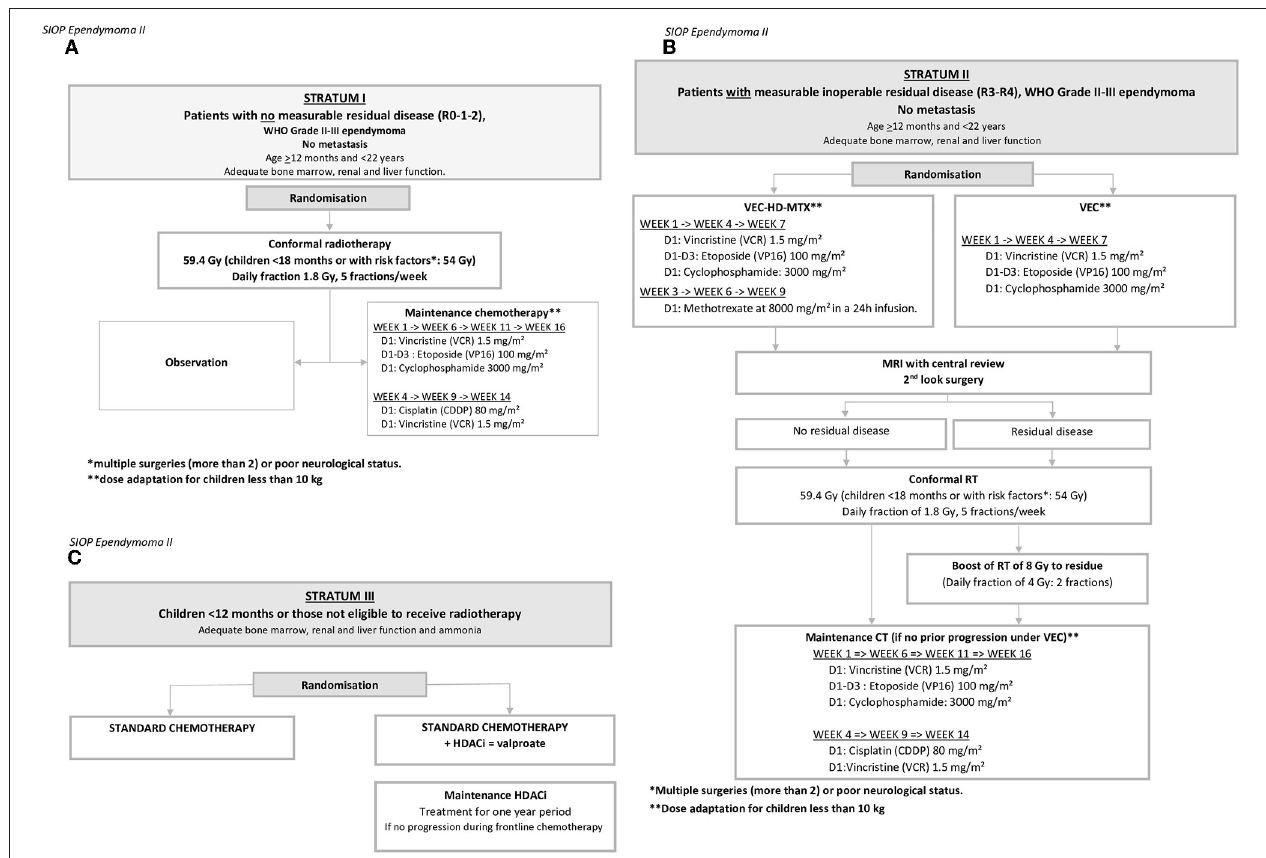
FIGURE 3 | Scheme of the three interventional strata. (A) Stratum I: Patients with no measurable residual disease (R0-1-2). (B) Stratum II: Patients with measurable inoperable residual disease (R3–R4), WHO Grade II–III ependymoma, no metastasis. (C) Children < 12 months or those not eligible to receive radiotherapy. *Multiple surgeries (more than 2) or poor neurological status; **Dose adaptation for children less than 10 kg. * multiple surgeries (more than 2) or poor neurological status; ** dose adaptation for children less than 10